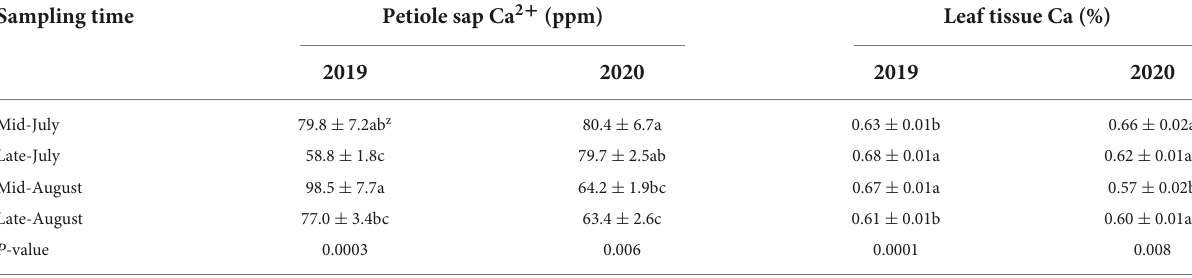
TABLE 4 “Meeker” floricane red raspberry petiole sap calcium (Ca 2 + ) and leaf tissue Ca concentrations by sampling time, 2019 and 2020. Sampling